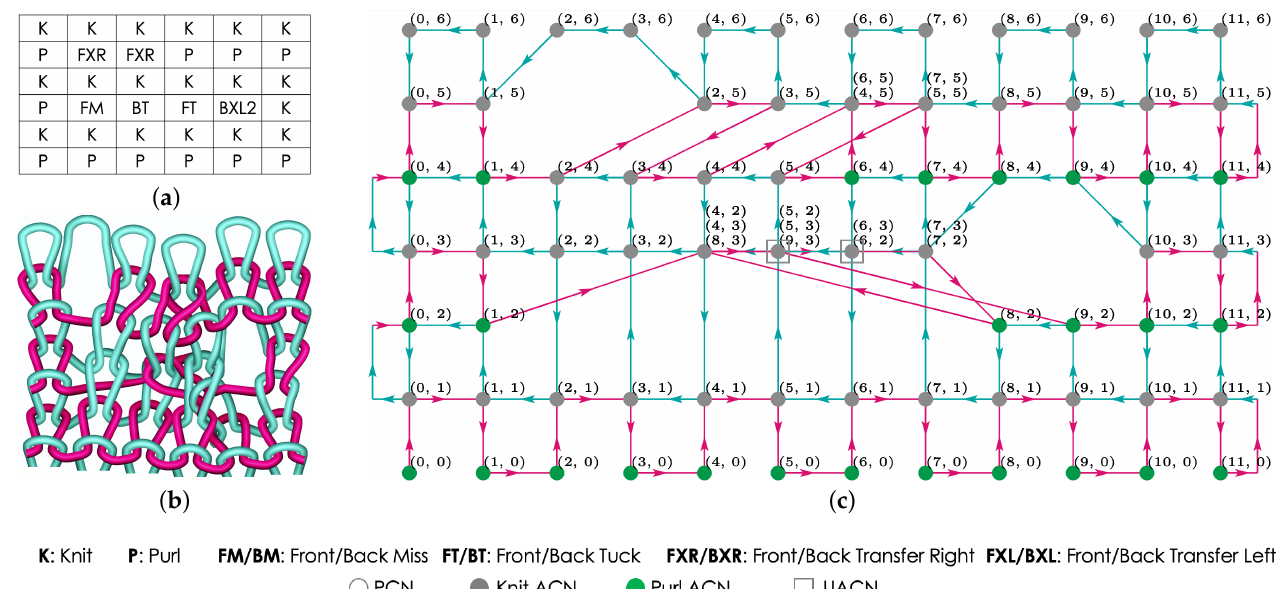
Figure 17. Stitch pattern with a combination of Knit, Purl, Front and Back Transfer, Front Miss, and Front and Back Tuck stitches: ( a ) Stitch instructions. ( b ) Simulated knitted pattern. ( c ) Topology graph displaying CN (loop)